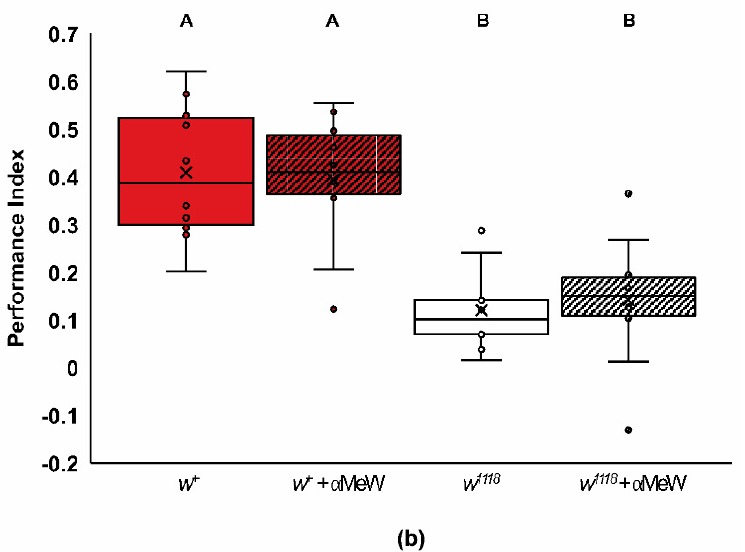
Figure 7. w 1118 mutants have increased levels of 5-HT within their heads. ( a ) 5-HT levels normalized against extracted protein concentrations are shown. Wildtype Canton-S ( w + ) and w 1118 mutant flies were treated with vehicle or 20 mM α -methyl-tryptophan ( α MeW) for 40 h. In vehicle-fed flies, 5-HT was significantly higher in the w 1118 mutants compared to wildtype flies (two-way ANOVA, Adj. R 2 = 0.891, F 3,20 = 63.549, p < 0.0001; Tukey post hoc for genotype, p < 0.01; n = 6). Additionally, α MeW significantly lowered the amount of 5-HT in the heads of both wildtype and w 1118 mutants (Tukey post hoc for treatment, p < 0.0001); ( b ) wildtype Canton-S ( w + ) and w 1118 mutant flies were fed vehicle or 20 mM α MeW and trained with a single trial. Acquisition in vehicle-fed wildtype and w 1118 mutants were significantly different, however there was no effect of α MeW treatment on one-trial learning (two-way ANOVA, Adj. R 2 = 0.519, F 3,36 = 15.05, p < 0.0001; Tukey post hoc, p < 0.05; n = 10). In panels a and b, groups that do not share letters above the box plots are significantly different from each other according to the Tukey post hoc test ( p < 0.05).